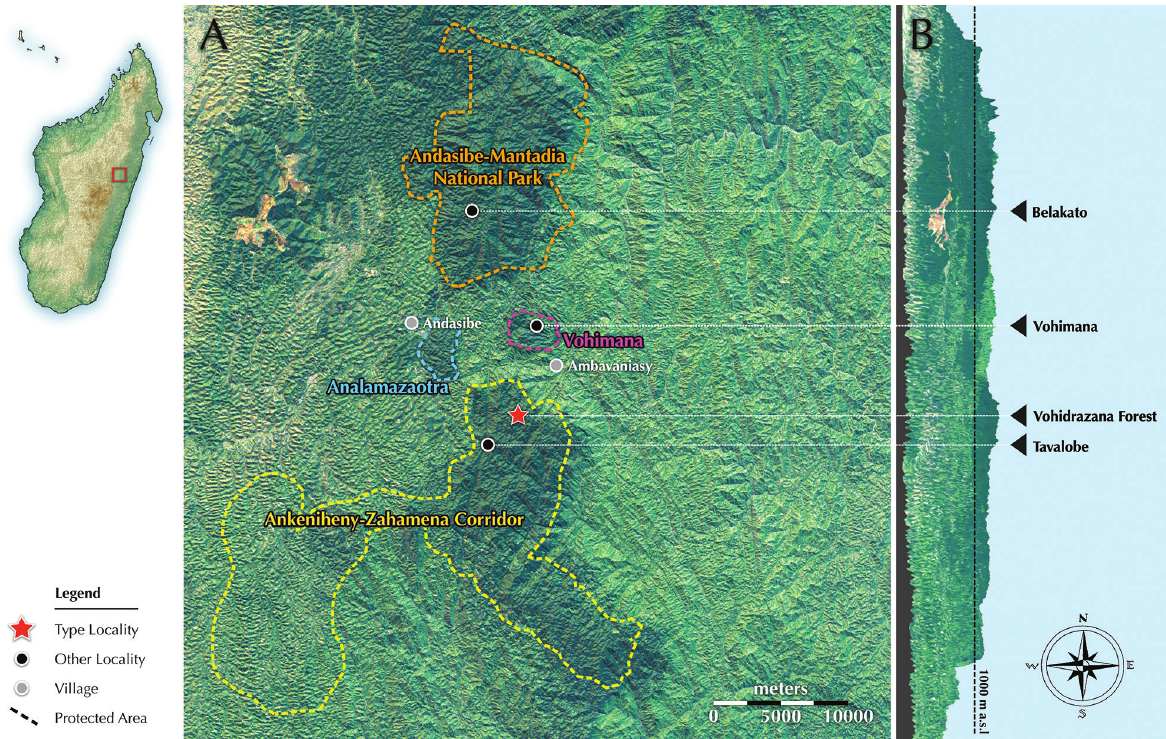
Figure 1. The distribution of Gephyromantis marokoroko sp. nov. in east-central Madagascar, view from above ( A. ) and from a profile view ( B. ). The black star marker indicates the type locality at Vohidrazana Forest where the black circle “locality” markers indicate other confirmed localities for the new species. Gephyromantis marokoroko sp. nov. is also found at high elevations and, thus, is likely distributed at other high elevation sites not surveyed. Elevational and satellite imagery data acquired from the USGS Earth Explorer (